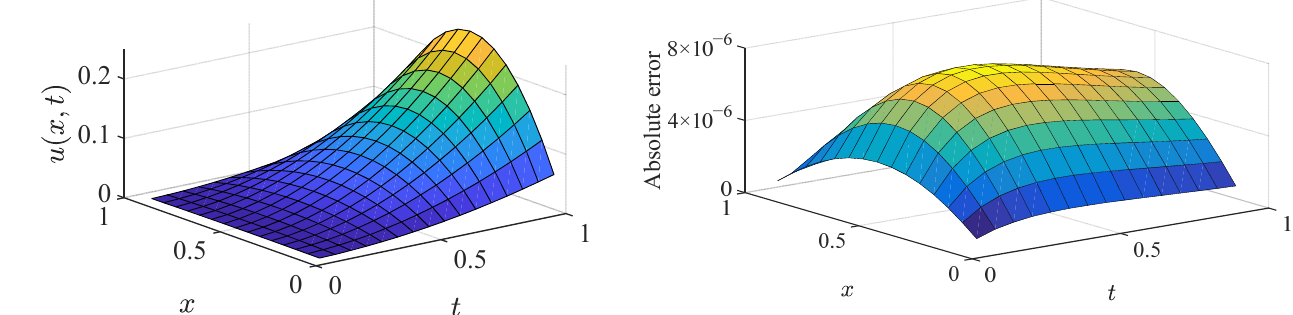
Figure 3. Wavelet solution ( Left ) and its absolute error ( Right ) under spatial mesh size ∆ h = 1/16